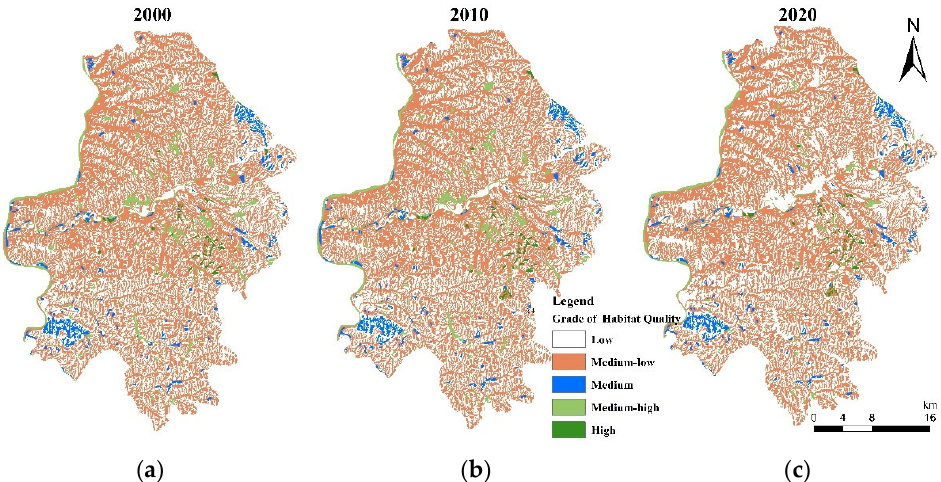
Table 5. Proportion of habitat quality area of different grades in Liulin County from 2000 to 2020.